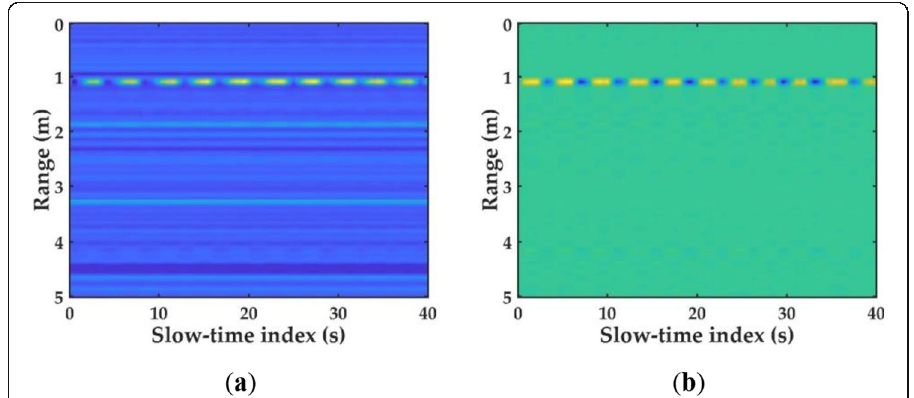
Fig. 3 Comparison of the raw echo data and corresponding preprocessed radar signal when a human target is approximately 1 m away from the UWB radar under free-space conditions. a Raw echo data. ( b Corresponding preprocessed radar